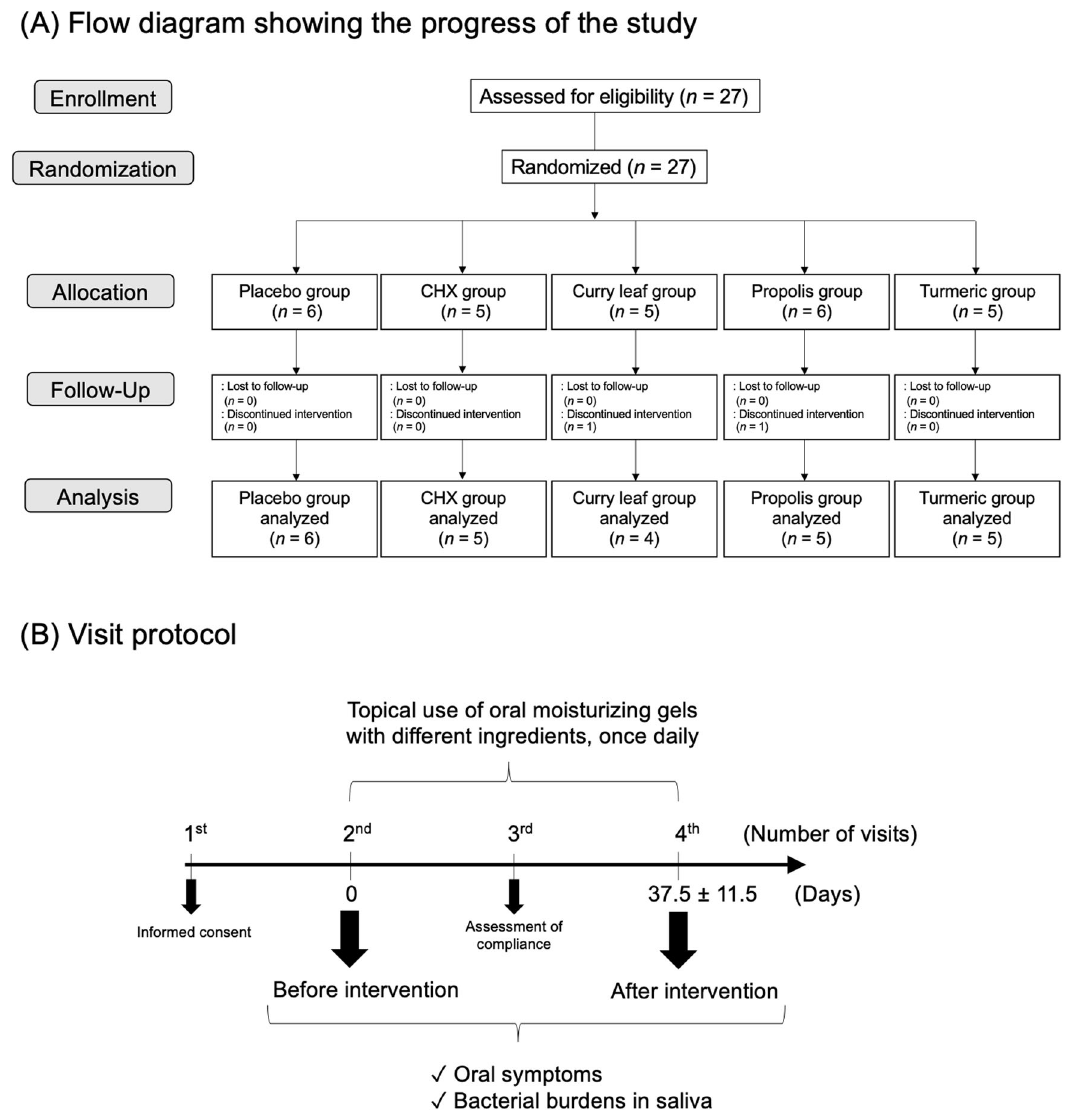
Fig. 1 Overview of the present study. A Flow diagram of study protocol. Twenty-seven subjects who ful fi lled the entrance criteria were registered between October 2016 and February 2017. They were randomly divided into fi ve groups and given a speci fi c oral moisturizing gel formulation to be applied at home. Each oral moisturizing gel contained one of the following fi ve ingredients: placebo, chlorhexidine, curry leaf, propolis, or turmeric. All except two dropout patients, who were assigned to the curry leaf and propolis groups (i.e., 25 subjects), were followed and analyzed. B Visit protocol. At the fi rst visit, informed consent was obtained from all patients. Sampling of saliva was performed before and after topical use of the oral moisturizing gels with different ingredients for 37.5 ± 11.5 days, i.e., at the second and fourth visits. To improve compliance with topical use of the gels at home, we checked compliance by interviewing each subject on an intermediate day of the intervention period, i.e., at the third visit. Of these participants, all except two patients who dropped out (25 subjects) were eventually enrolled and analyzed in the present